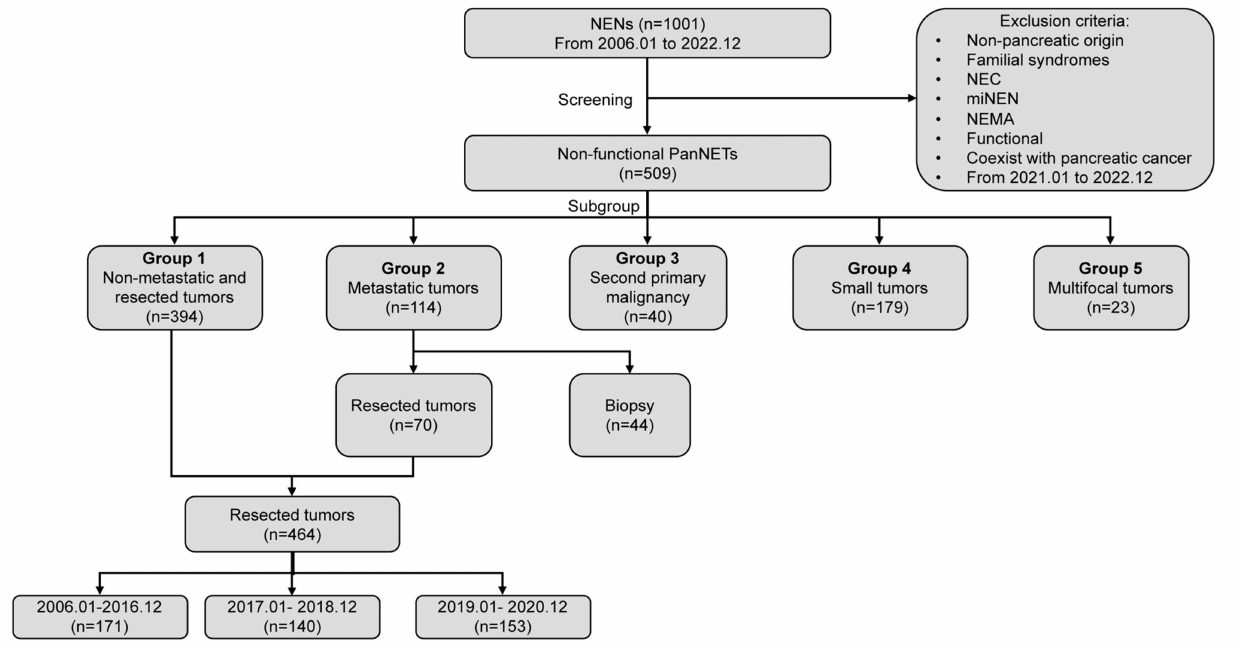
Figure 1. Flow diagram of patient selection. NENs: neuroendocrine neoplasms; NEC: neuroendocrine carcinoma; miNEN: mixed neuroendocrine-non-neuroendocrine neoplasms; NEMA: neuroendocrine microadenoma; PanNETs: pancreatic neuroendocrine